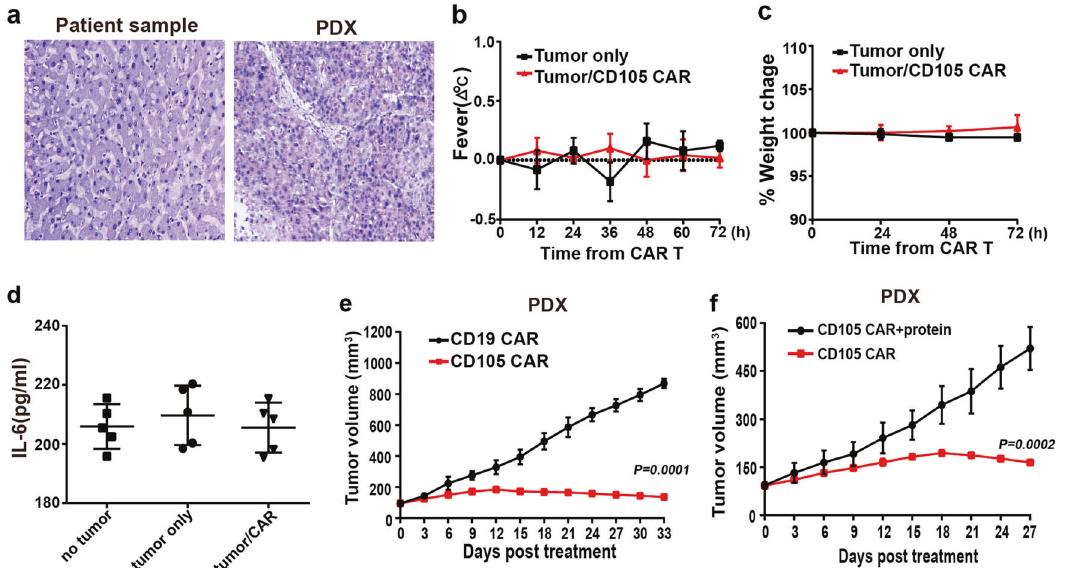
Fig. 6 CD105 CAR-T cells ef fi ciently inhibit growth of patient-derived xenograft (PDX) of hepatocellular carcinoma. a H&E staining tissue of primary tumor and PDX. The xenograft demonstrates morphology consistent with the original human tumor. The change of body temperature and weight ( b , c n = 5) was calculated. The serum levels of IL-6 ( d ) was measured by ELISA ( n = 5). e Growth curve of PDX ( n = 5) treated with the CD19 or CD105 CAR-T cells at indicated time point. At the end of the experiment, the tumors treated with CD105 CAR-T cells were signi fi cantly smaller than CD19 CAR-T group. f CD105 CAR-T was incubated with CD105 protein for 30 min, tumor-bearing mice were injected with CD105 CAR -T cells in PDX models. The results show that the antitumor effect of CD105 CAR-T is reduced after incubated